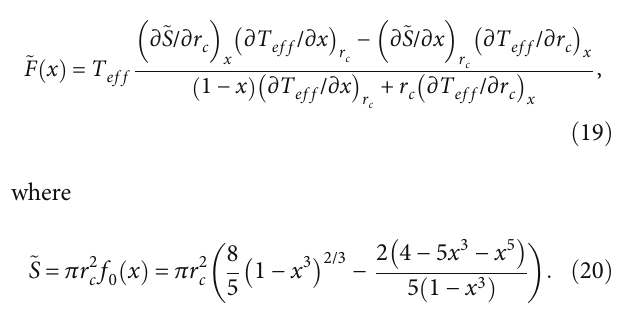
Figure 8: (color online). ~ F ð x Þ − x curves with 1/ r 2 l 2 ð 1 − xQ 2 / r 2 Þ , and solid blue line for ϕ 2 + for ϕ 2 + = 0 : 04 , and solid red line for ϕ 2 + = 0 : 05 ,